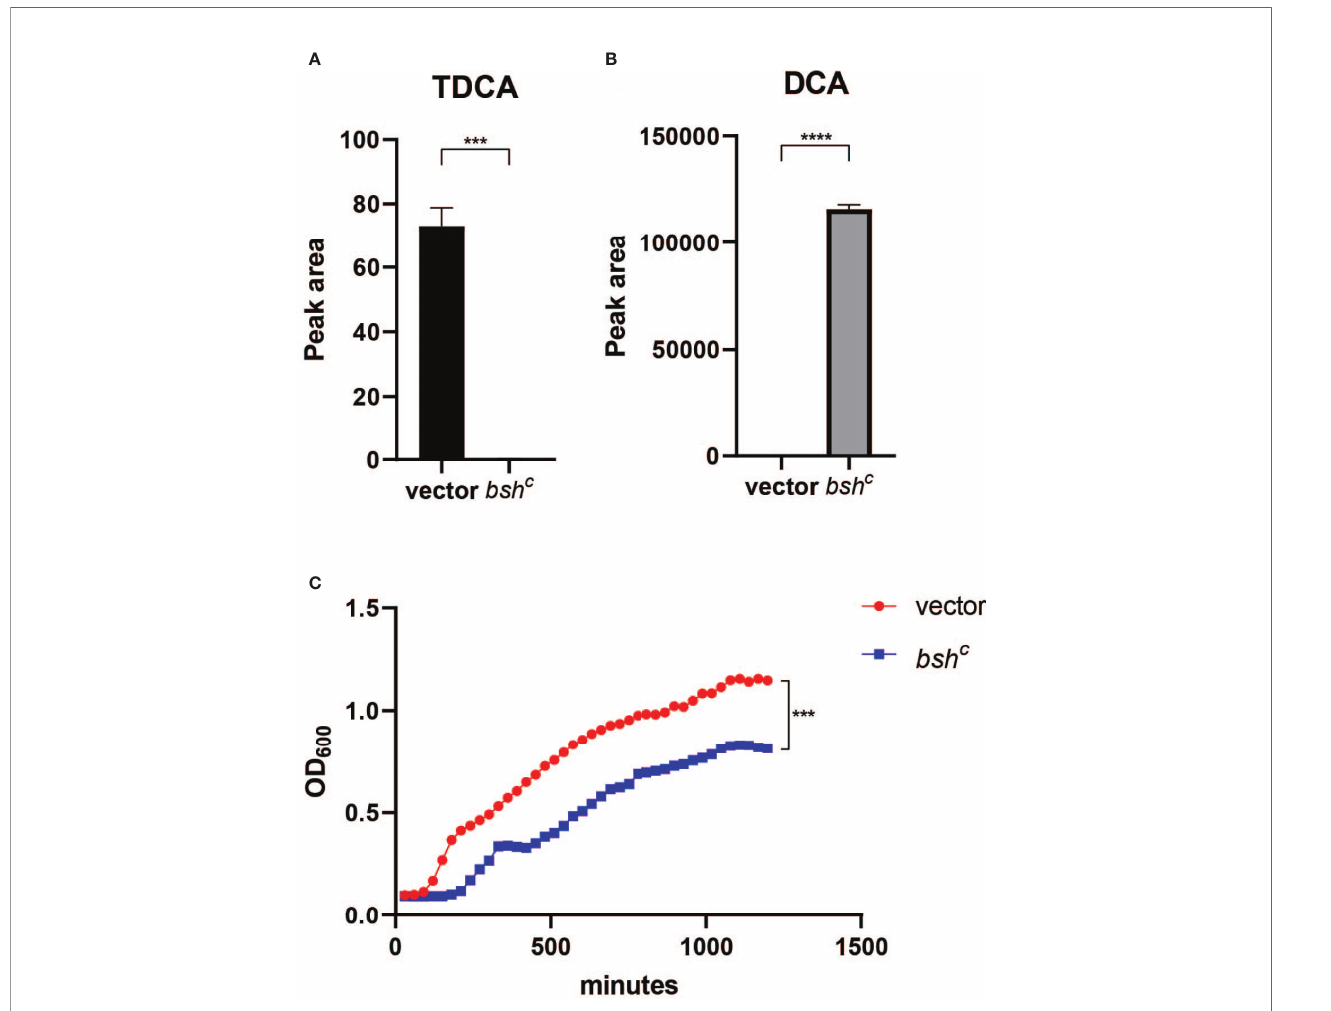
FIGURE 6 | Blautia obeum bile salt hydrolase processes TDCA to DCA leading to inhibition of V. cholerae growth. (A) TDCA and (B) DCA levels after 24-h incubation of 2 mM TDCA with E. coli vector and bsh c strains as measured by mass spectrometry. (C) Effect on V. cholerae growth in vitro of addition of fi ltered supernatants from TDCA incubation with the indicated strains (n = 4, t test, ***P < 0.001; ****P <